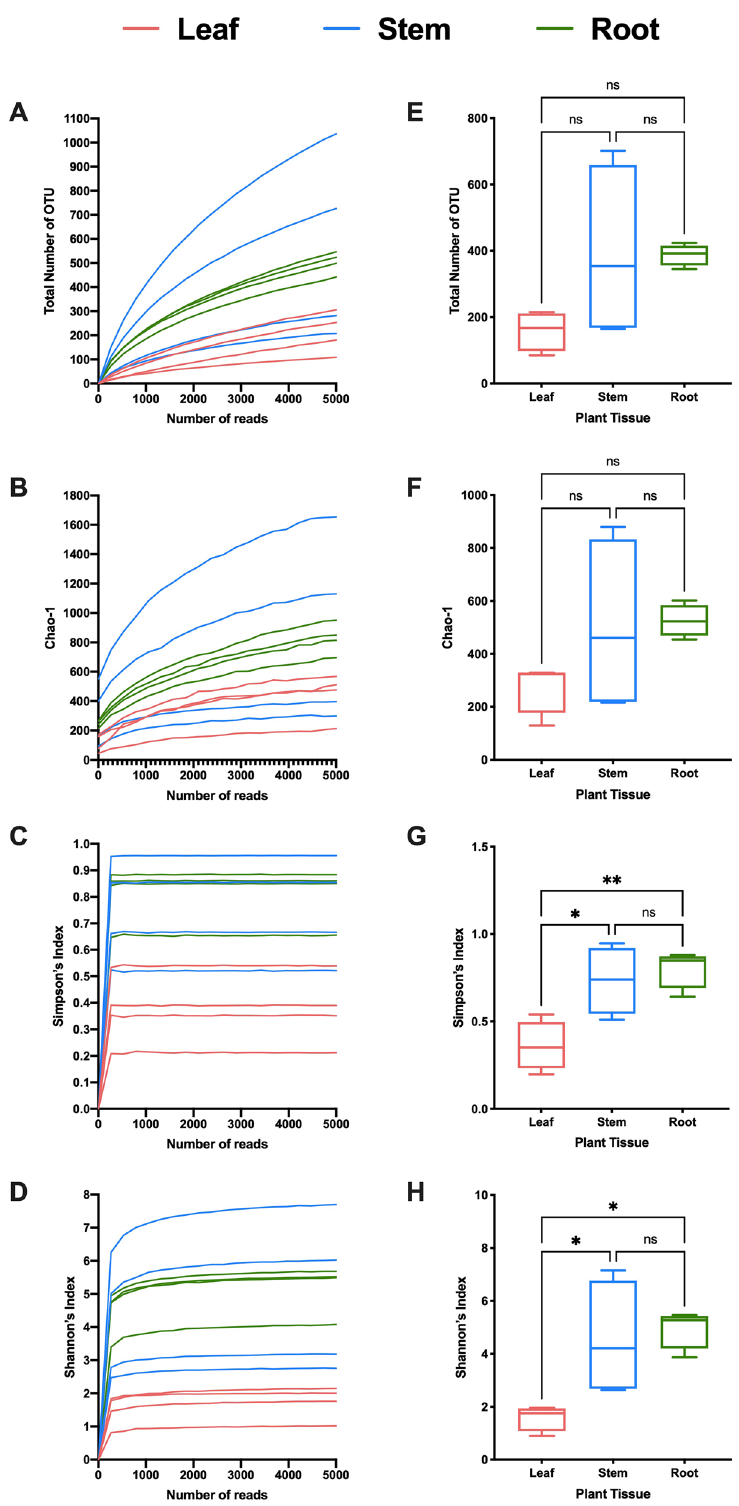
Figure 2. Alpha diversity in Panax quinquefolius tissues. ( A – D ) Rarefaction curves indicating sufficient depth of sequencing based on ( A ) Total number of operational taxonomic units (OUT), ( B ) Chao-1 index, ( C ) Simpson’s index, and ( D ) Shannon’s index. ( E – H ) Alpha diversity in Panax quinquefolius tissues based on ( E ) Total number of OTU, ( F ) Chao-1 index, ( G ) Simpson’s index, and ( H ) Shannon’s